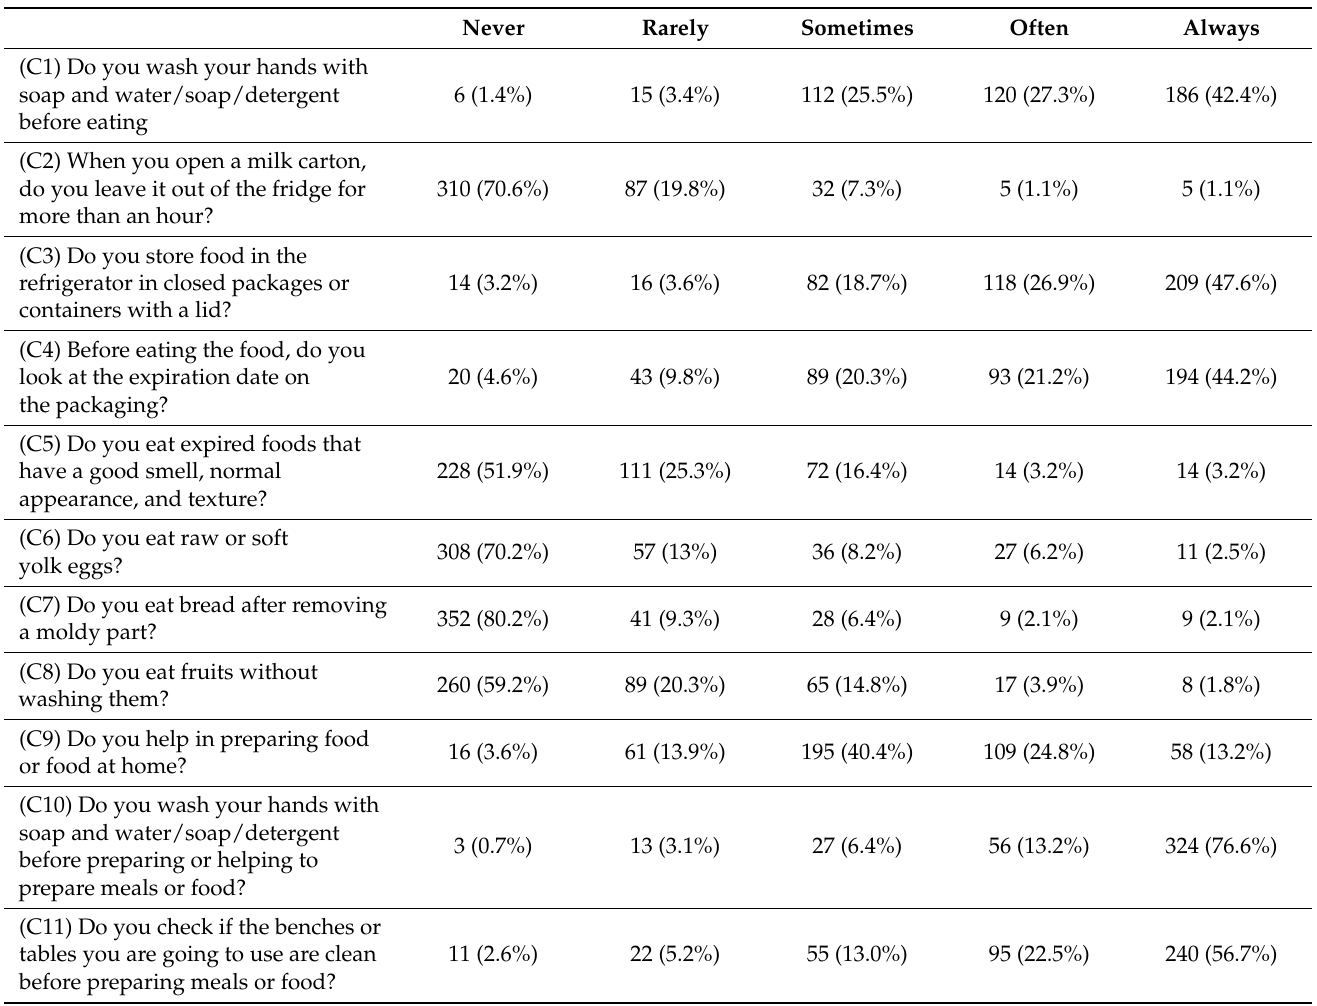
Table 5. Relative and absolute frequencies of responses to the practice’s